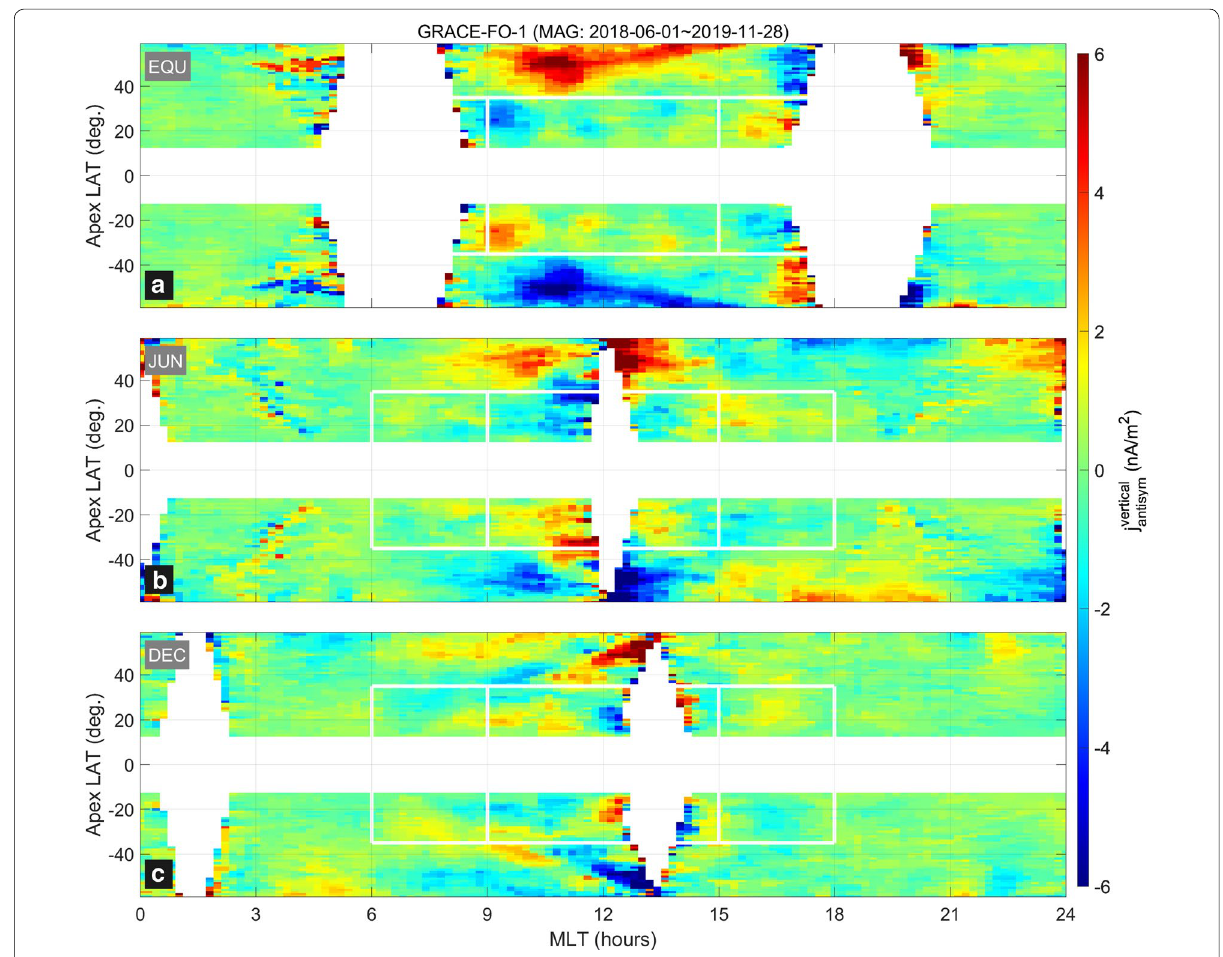
Fig. 7 The same as Fig. 6, but from